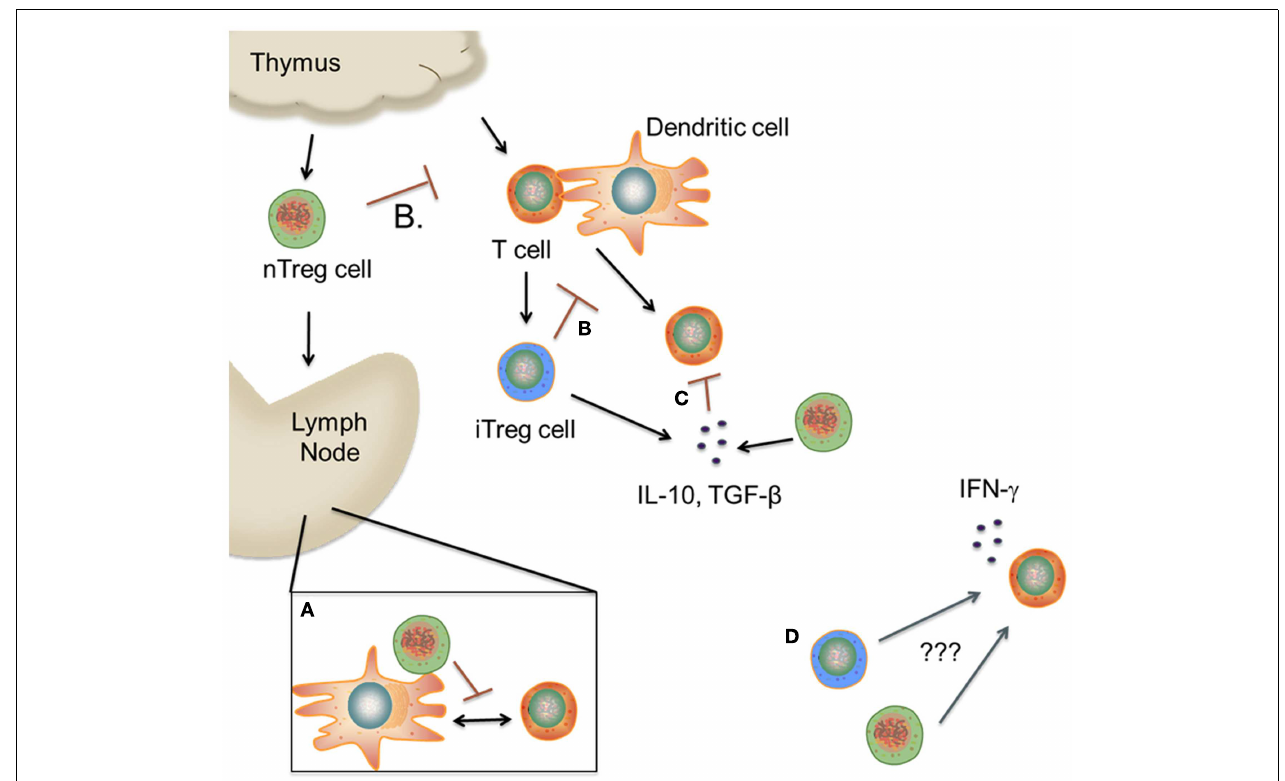
receptors, and release of suppressive cytokines. (D) A subset of nTreg and iTreg cells lose Foxp3 expression and begin to secrete proinflammatory cytokines due to unknown environmental cues.The role of these cells in mediating pathological damage during GVHD is unknown. (This figure was created usingVisi ScienceSlides®